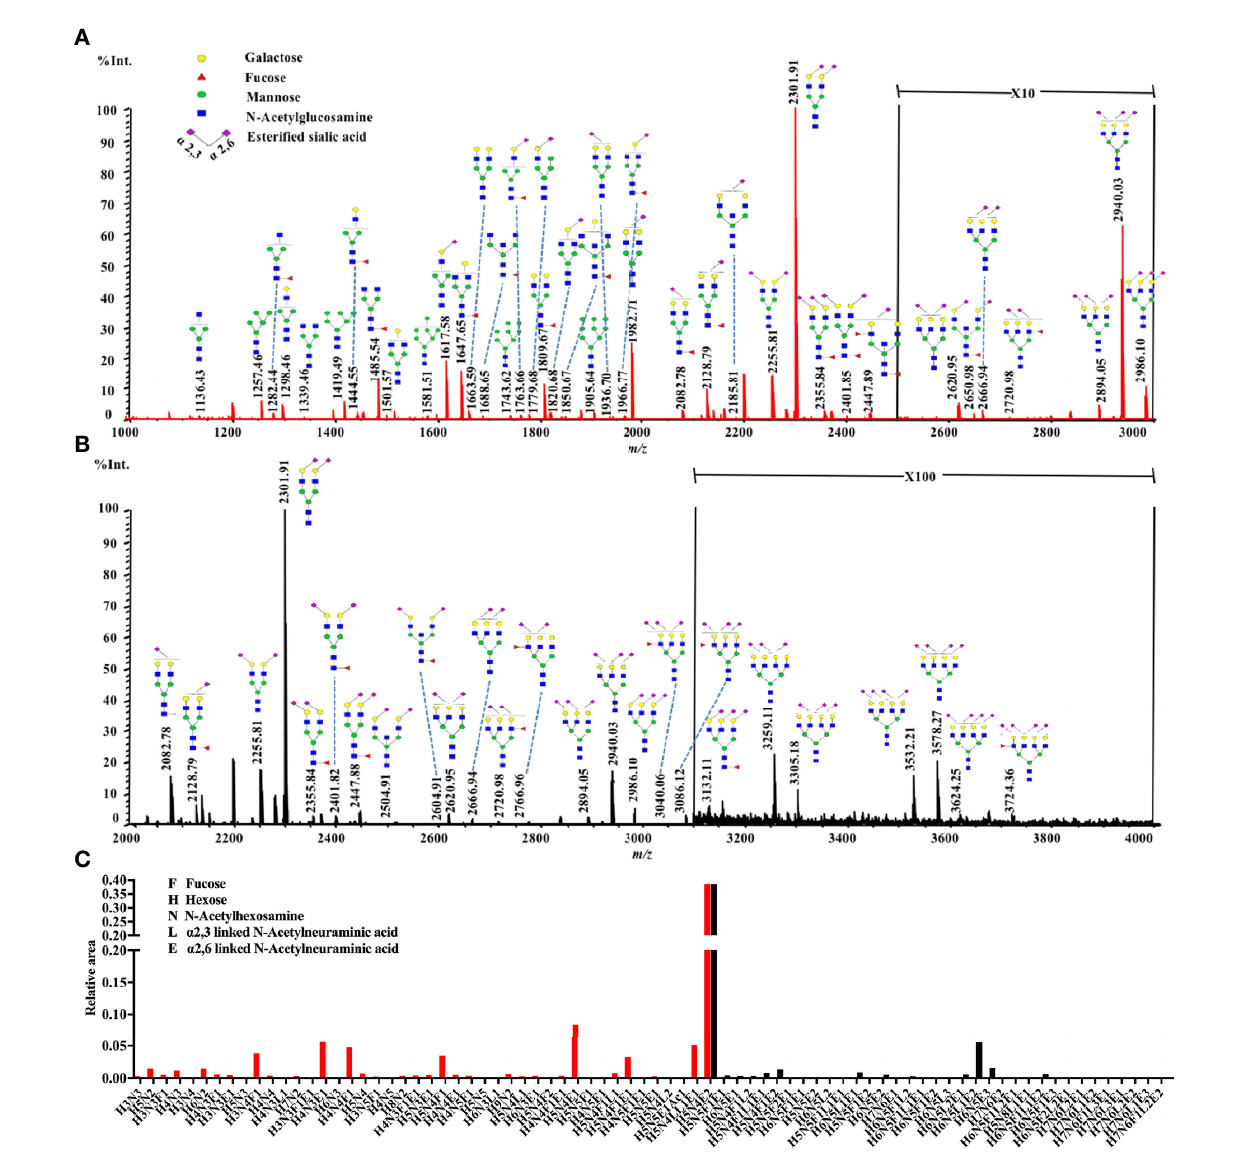
FIGURE 1 | A typical MALDI-QIT-TOF MS spectrum of serum N-glycan pro fi les from a serum sample. (A) The representative spectrum of low-mass measurement (approximately m/z 1,000 to 3,000). (B) The representative spectrum of high-mass measurement (approximately m/z 2,000 to 4,000). (C) Combination of the low mass (red) and high mass (black) area integration originating from a single spot. The relative areas were normalized to the peak at m/z 2301.91, re fl ecting the N-glycan composition [H5N4E2 + Na] +